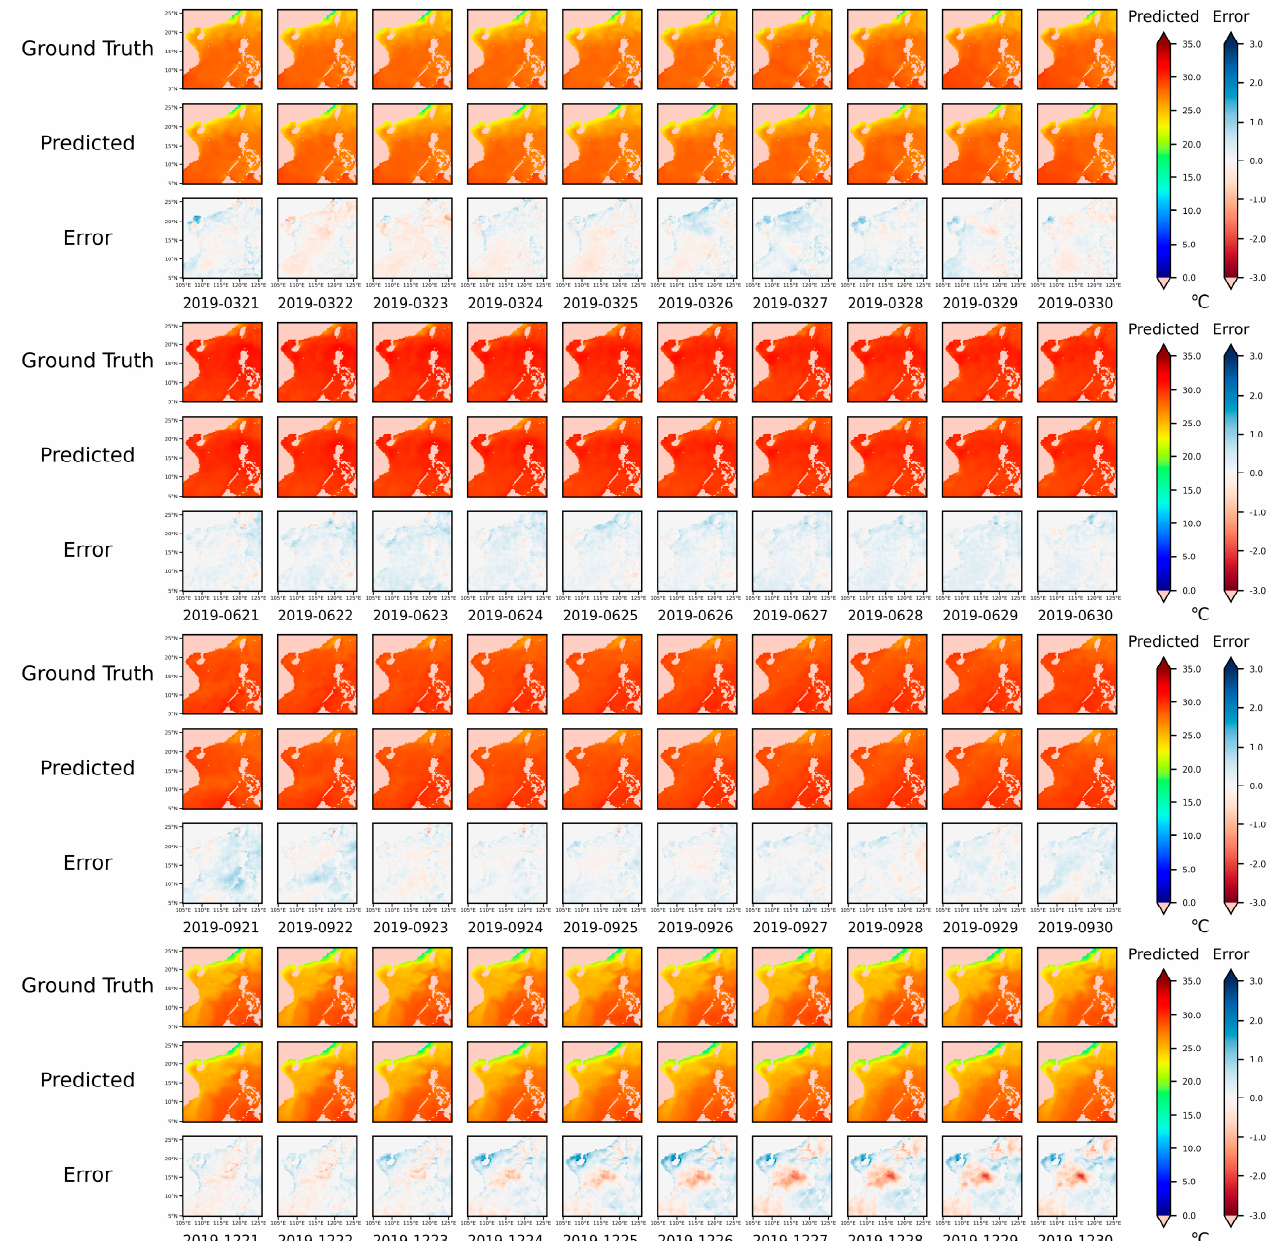
Figure 13. Visualization of the ST-ConvLSTM predicted SST for the next 10 days. The South China Sea is a tropical ocean with high sea surface temperatures, but due to the large latitudinal span and the influence of monsoons and currents, there are differences in the distribution of surface water temperatures between the north and south. From Figures 12 and 13, the smaller the value of “Error”, the whiter the image as a whole. When using ConvLSTM and ST-ConvLSTM to predict SST, the predicted values of SST in March and December are higher overall; the predicted values of SST in June and September are lower overall. The highest error of the ConvLSTM prediction reaches − 3.3055 in March, and the highest error of the ST-ConvLSTM prediction reaches 2.7281 in December. The possible reason is that the ocean dynamics in the South China Sea are complex, and the mechanism behind the change is not fully learned. We take December as an example, and it is obvious that the ConvLSTM predicts better than the ST-ConvLSTM. So although ST-ConvLSTM is an improved version of ConvLSTM, it is not the case that